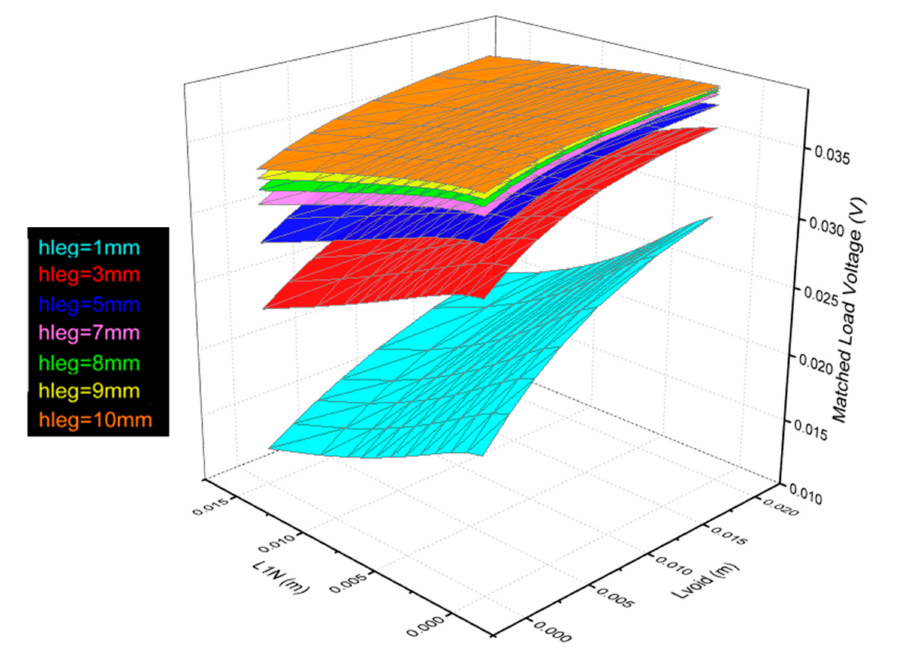
Figure 13. Matched load voltage of a pair as a function of n-type diameter, L 1 N , and element spacing, L void , for several element thicknesses, h leg .